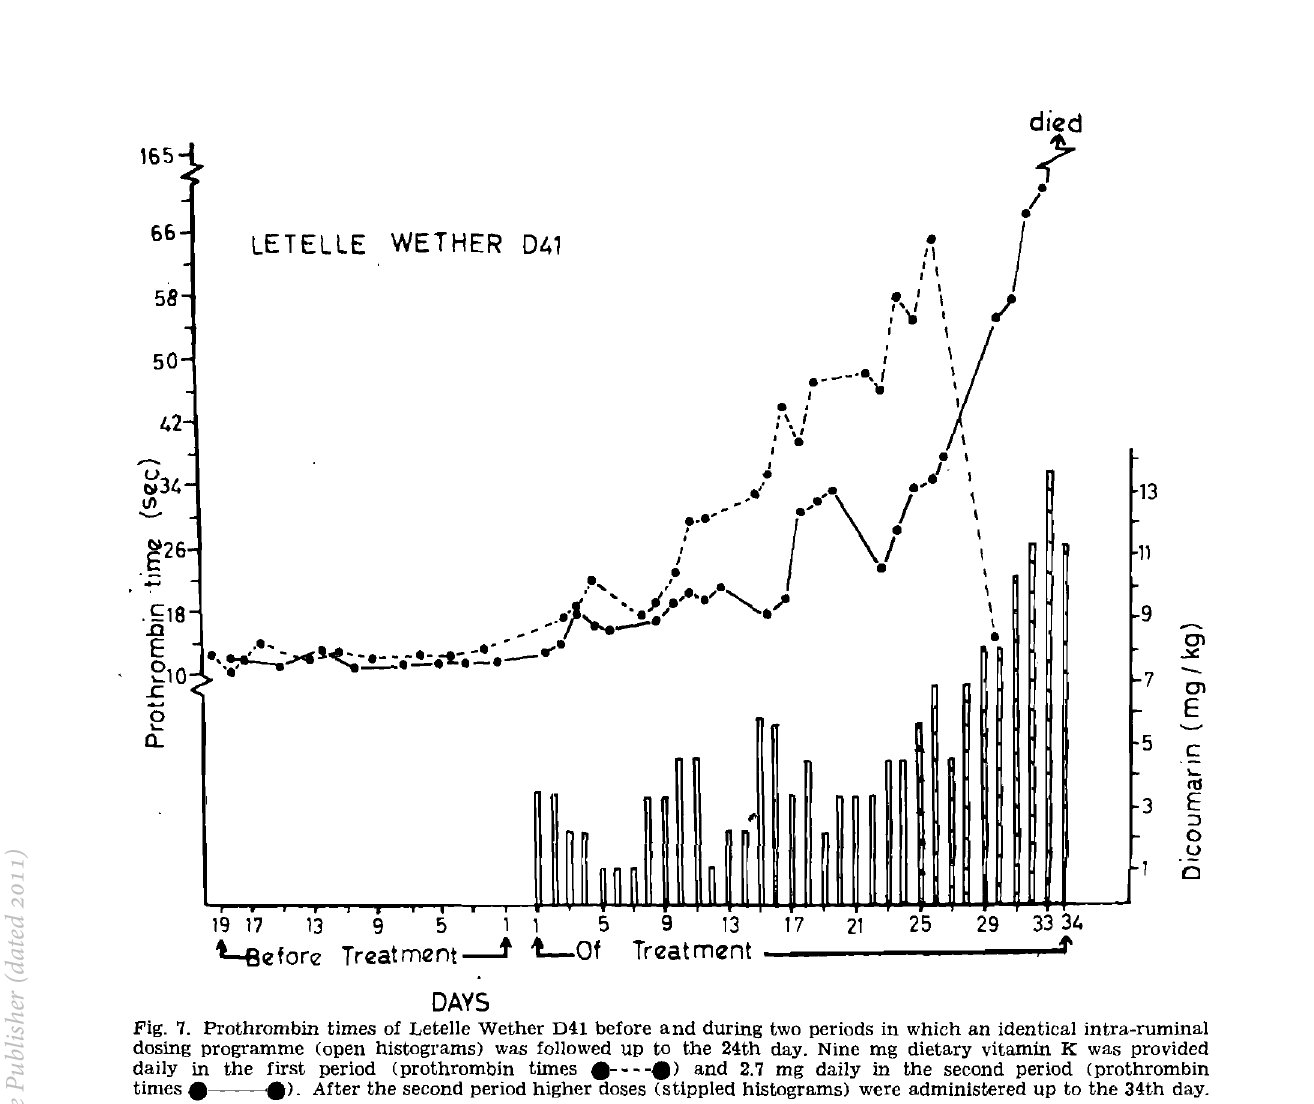
Fig. 7. Prothrombin times of Letelle Wether D41 before and during two periods in which an identical intra-ruminal dosing programme (open histograms) was followed up to the 24th day. Nine mg dietary vitamin K was provided daily in the first period (prothrombin times .-- - -.) and 2.7 mg daily in the second period (prothrombin e). times. After the second period higher doses (stippled histograms) were administered up to the 34th day.